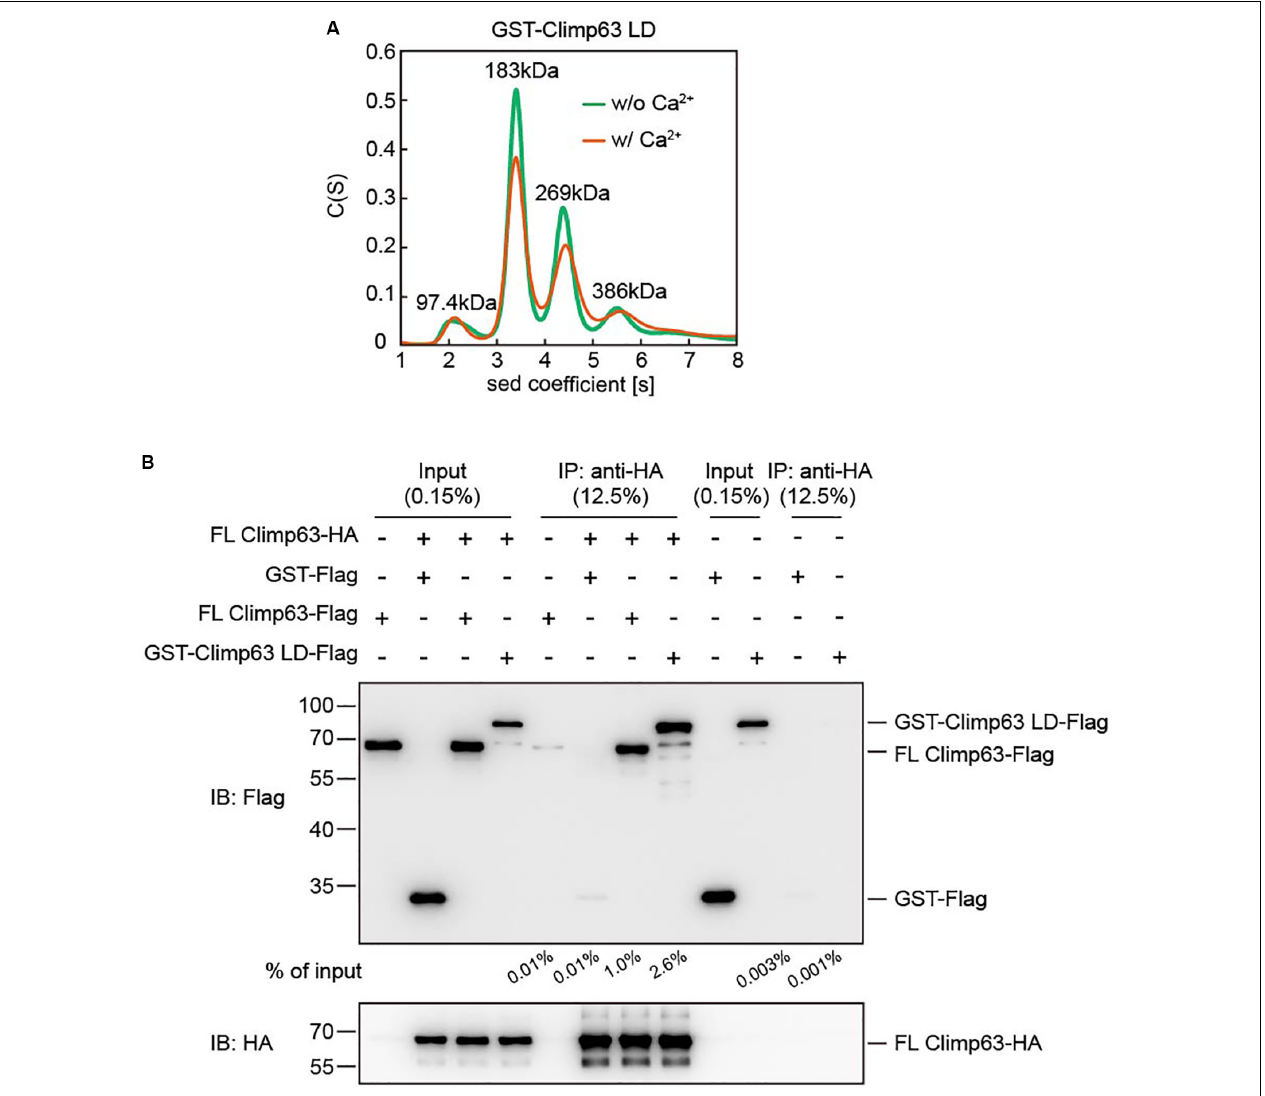
FIGURE 2 | Interactions between purified Climp63. (A) The size of GST-Climp63 LD (theoretical molecular weight: 80.3 kDa) was determined at 12.5 µ M by analytical ultracentrifugation (AUC) with or without 2 mM CaCl 2 . The estimated molecular masses are given above the peaks (in kilodaltons, kDa). (B) The interaction between purified FL Climp63-HA and FL Climp63-Flag was determined by co-immunoprecipitation. 5 µ g of purified Climp63-HA (0.16 µ M) was immunoprecipitated by anti-HA-agarose and then incubated with 10 µ g of Flag-tagged protein, including FL Climp63-Flag (0.32 µ M), GST-Climp63 LD-Flag (0.25 µ M), or GST-Flag (0.8 µ M), at 4 ◦ C for 1.5 h. The samples were analyzed by immunoblotting using the indicated antibodies. 0.15% of the input and 12.5% of the precipitate was loaded. The relative levels of co-precipitated Flag-proteins were quantified using the Gel-Pro analyzer software and normalized to the levels of input. Data are representative of three biological